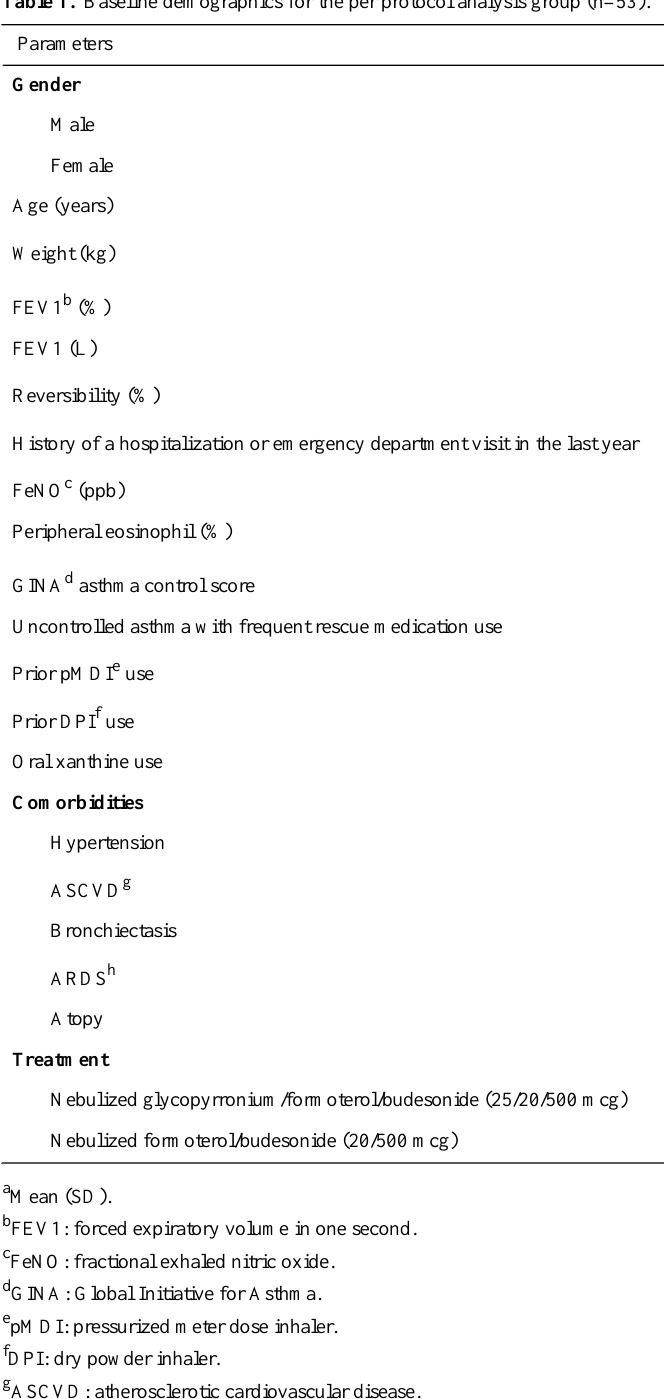
Table 1. Baseline demographics for the per protocol analysis group